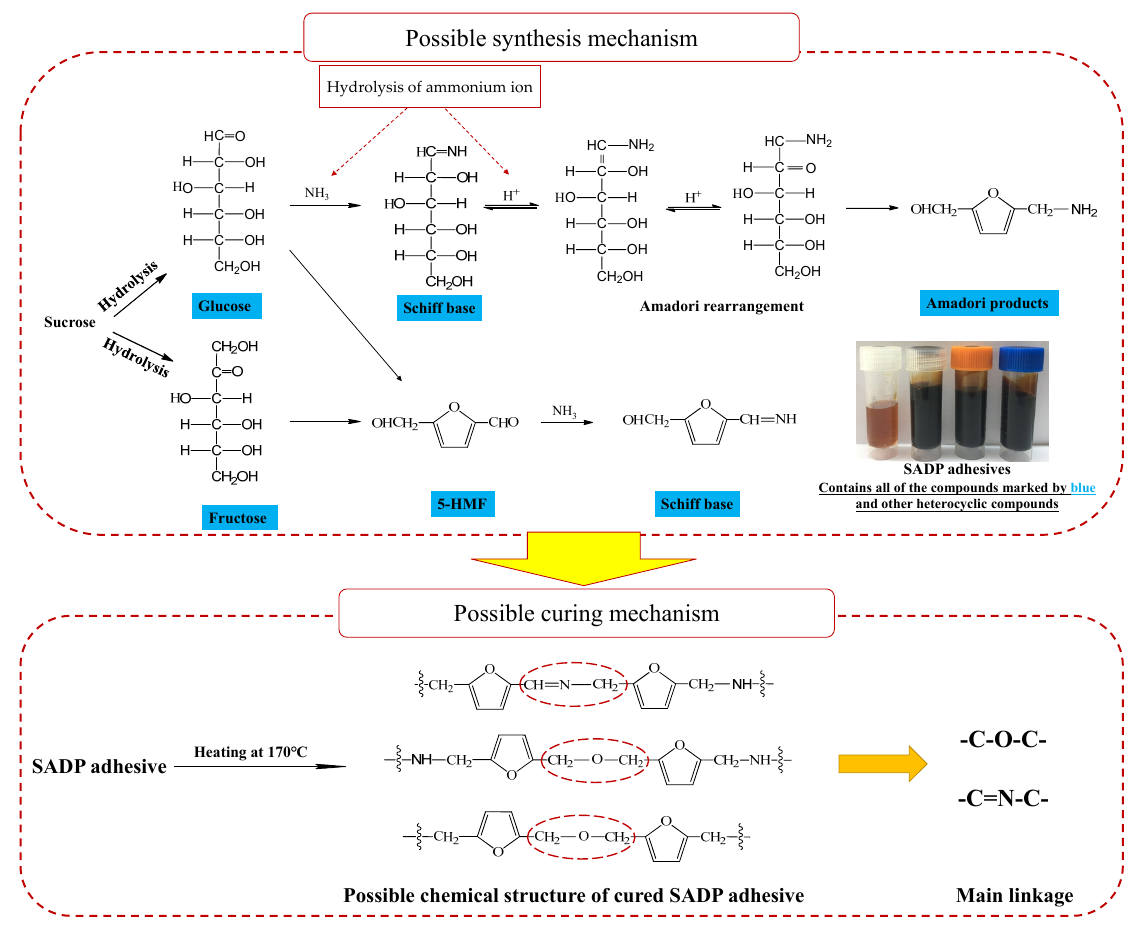
Figure 11. Possible synthesis and curing mechanism for SADP adhesive.